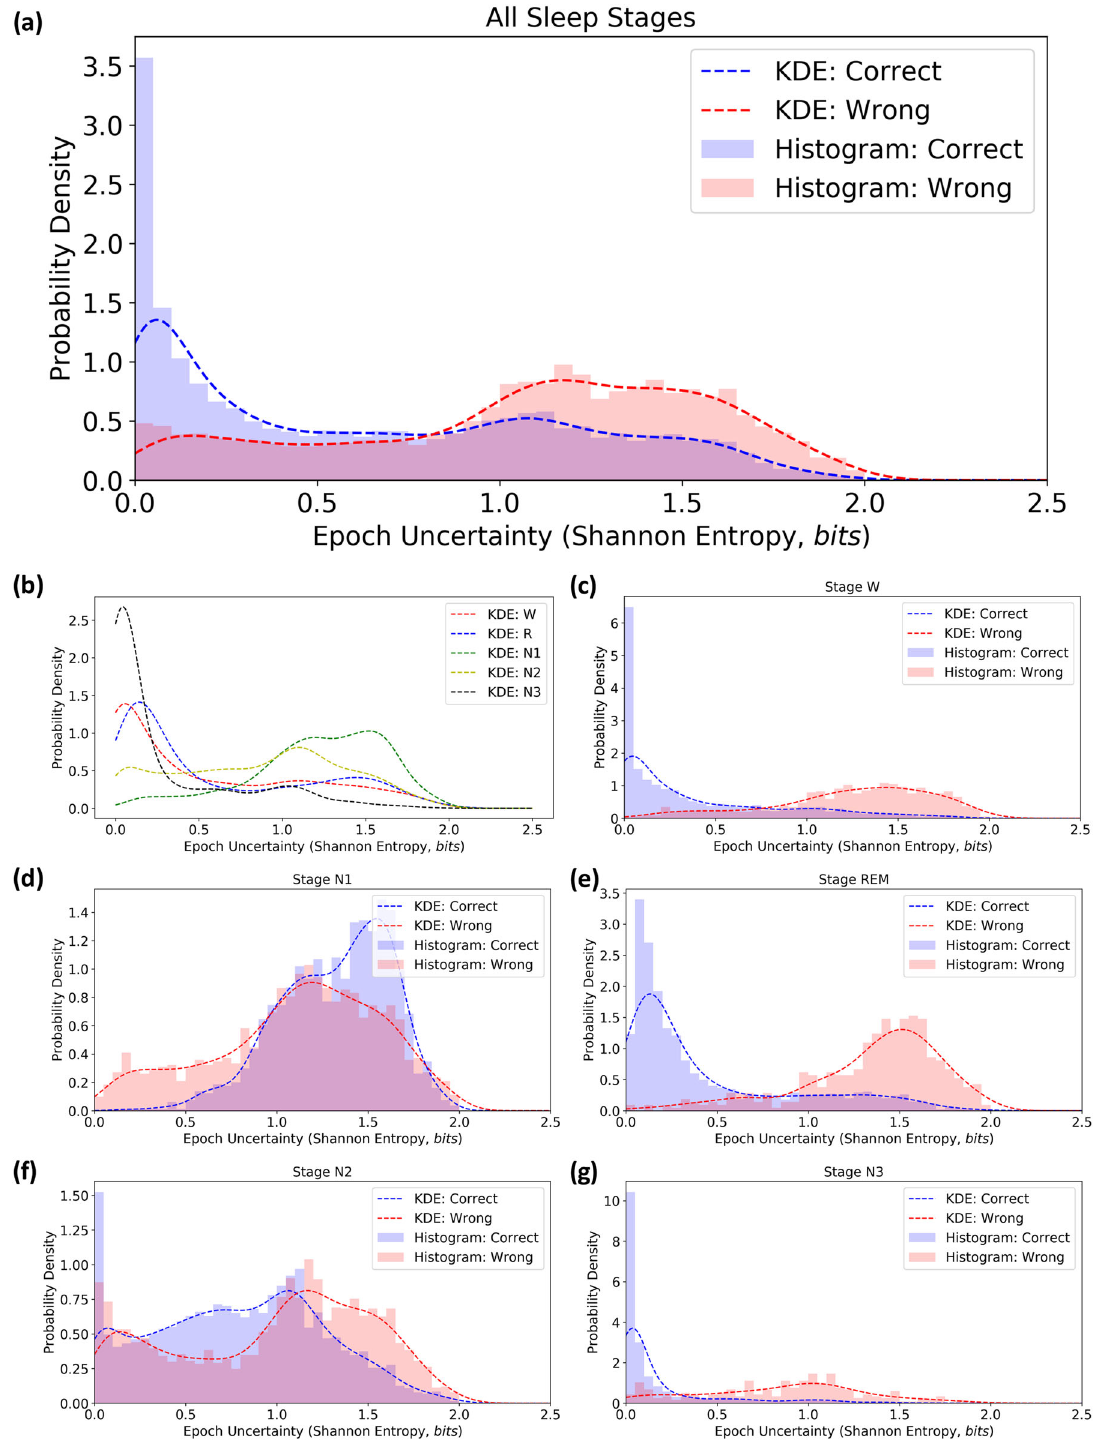
Fig. 4 Entropy distribution plots for all and per-stage distributions using HMM-based classi fi cation. a Shannon entropy distribution + correctness for all stages. b Shannon entropy distribution per class. Shannon entropy distribution and correctness for stage: c W (3602 epochs), d REM (2320 epochs), e N1 (3222 epochs), f N2 (6653 epochs), and g N3 (1629